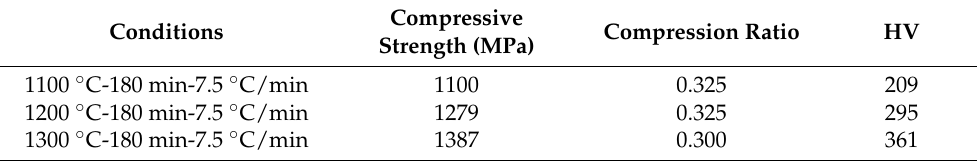
Figure 7. The compression curves of these samples when sintered at ( a ) 1300 °C, ( b ) 1200 °C and ( c ) 1100 °C.